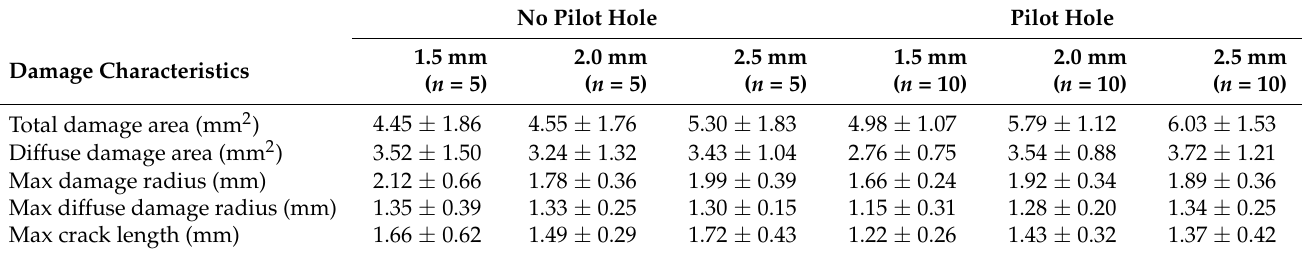
Table 2. Observed mean and standard deviation for each damage characteristic according to pilot hole status and bone thickness. No Pilot Hole Pilot